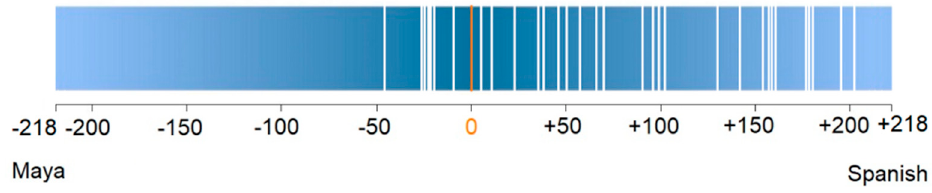
Figure 1. Bilingual Language Profile scores of participants (N = 34). Each individual score is indicated by a white vertical line.